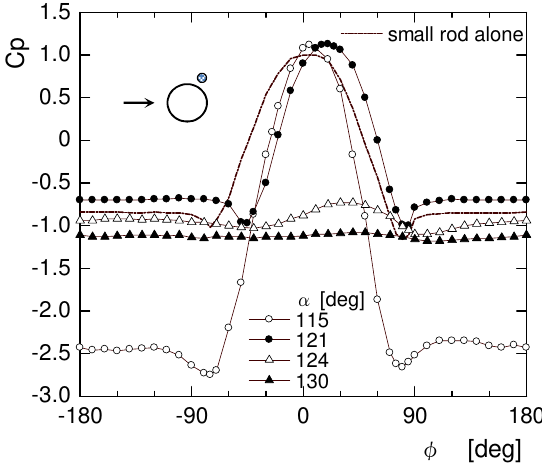
Fig. 7. Drag coefficients of the circular cylinder, the small rod and the total drag coefficient